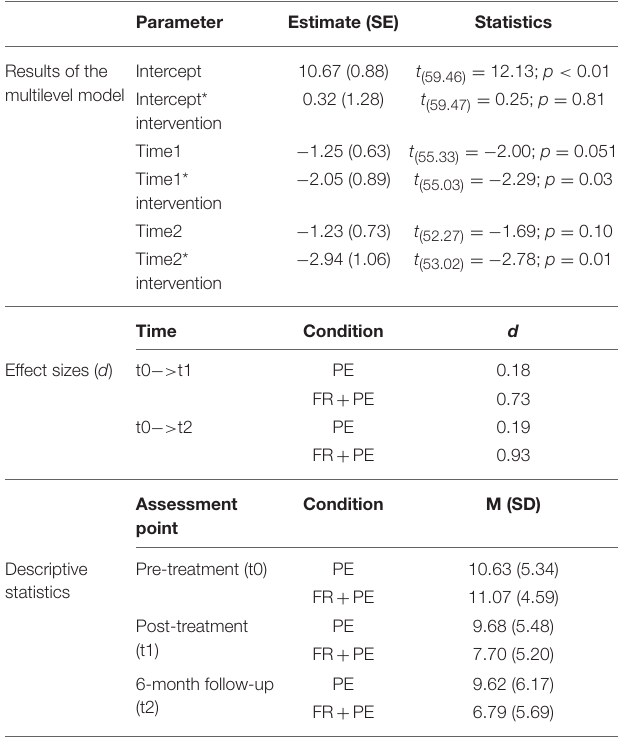
TABLE 4 | Results for the secondary outcome somatization measured with the somatization scale of the “Patient Health Questionnaire” (PHQ-15).